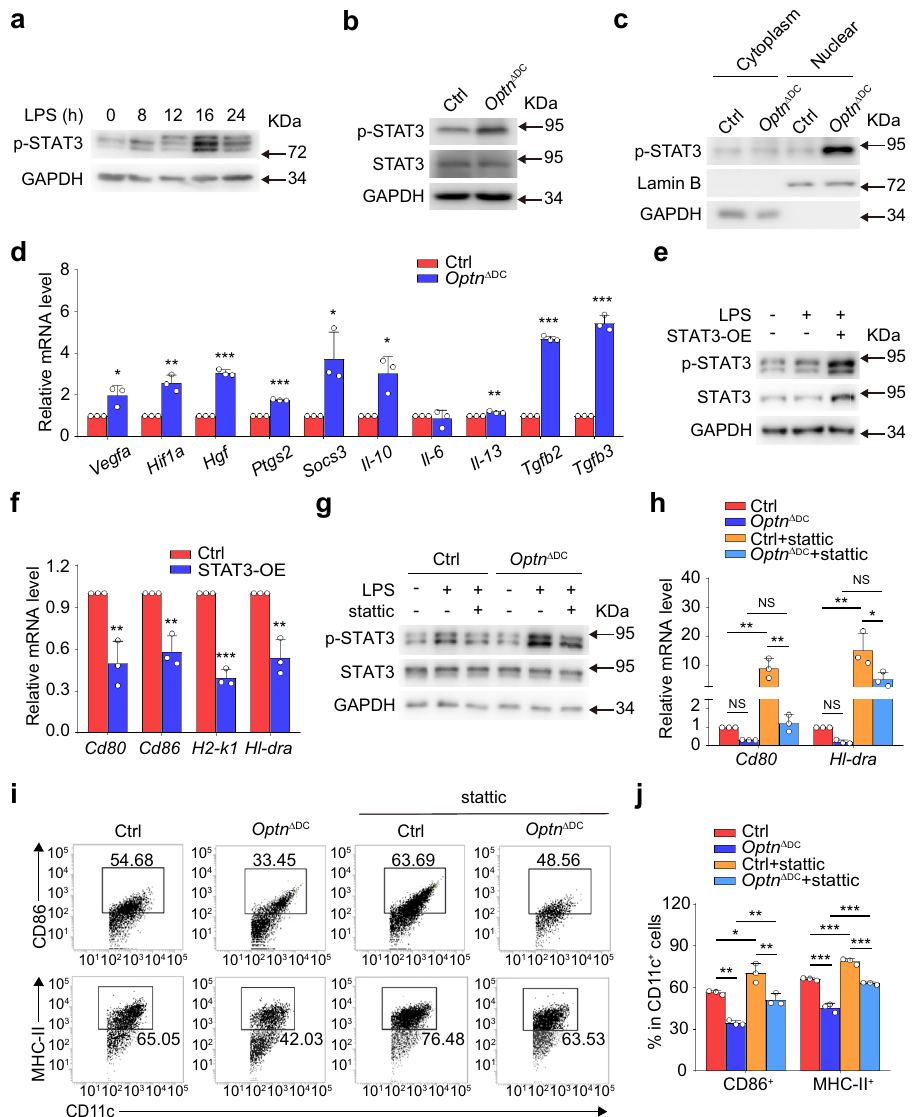
Fig. 4 STAT3 participates in OPTN-regulated DC maturation. a Expression of p-STAT3 in BMDCs stimulated with LPS for different time. n = 3 independent experiments. b Expression of (p)-STAT3 in Ctrl or Optn knockout BMDCs stimulated with LPS for 8h. n = 3 independent experiments. c Cytoplasmic and nuclear proteins from Ctrl and Optn knockout BMDCs were analyzed by western blotting. The nuclear marker Lamin B and the cytoplasmic marker GAPDH were used to demonstrate the purity of the fractions. n = 3 independent experiments. d qRT-PCR analysis of STAT3 target genes in Ctrl and Optn knockout BMDCs. n = 3 independent experiments, P ( Vegfa ) = 0.0238, P ( Hif1a ) = 0.0023, P ( Hgf ) = 1.8E − 05, P ( Ptgs2 ) = 2.1E − 06, P ( Socs3 ) = 0.0205, P ( Il-10 ) = 0.0137, P ( Il-13 ) = 0.0076, P ( Tgfb2 ) = 8.9E − 07, P ( Tgfb3 ) = 3.1E − 05. e , f Ctrl BMDCs were transfected with STAT3-overexpression (OE) plasmid. mRNA level of Cd80 , Cd86 , H2-k1 , and Hl- dra were analyzed by qRT-PCR. n = 3 independent experiments, P ( Cd80 ) = 0.0056, P ( Cd86 ) = 0.0031, P ( H2-k1 ) = 6.4E − 05, P ( Hl-dra ) = 0.0034. g – j Ctrl and Optn knockout BMDCs were treated with stattic (10 μ M) before LPS stimulation. Expression of Cd80 , Hl-dra ( h ) and CD86, MHC-II ( i , j ) were analyzed by qRT- PCR and fl ow cytometry, respectively. n = 3 independent experiments, P ( Optn Δ DC -Ctrl) = 0.9612, P (Ctrl + stattic-Ctrl) = 0.0025, P ( Optn Δ DC + stattic- Optn Δ DC ) = 0.9157, P ( Optn Δ DC + stattic-Ctrl + stattic) = 0.0030 of Cd80 in ( h ); P ( Optn Δ DC -Ctrl) = 0.9902, P (Ctrl + stattic-Ctrl) = 0.0031, P ( Optn Δ DC + stattic- Optn Δ DC ) = 0.3368, P ( Optn Δ DC + stattic-Ctrl Δ DC Δ DC Δ DC Δ DC = 0.00105, P = 0.0153, P = 0.0057, P + stattic) = 0.0208 of Hl-dra in ( h ); P ( Optn + stattic- Optn + stattic-Ctrl + stattic) = 0.0024 of -Ctrl) (Ctrl + stattic-Ctrl) ( Optn ) ( Optn CD86 in ( j ); P ( Optn Δ DC -Ctrl) = 6.5E − 06, P (Ctrl + stattic-Ctrl) = 0.0002, P ( Optn Δ DC + stattic- Optn Δ DC ) = 2.2E − 05, P ( Optn Δ DC + stattic-Ctrl + stattic) = 4.7E − 05 of MHC-II in ( j ). Data are presented as means±SD. * P <0.05; ** P <0.01; *** P <0.001; NS, not signi fi cant. Unpaired two-tailed Student ’ s t -test for ( d , f ); one-way ANOVA Tukey ’ s post hoc analysis for ( h , j ). Source data are provided in Source data fi